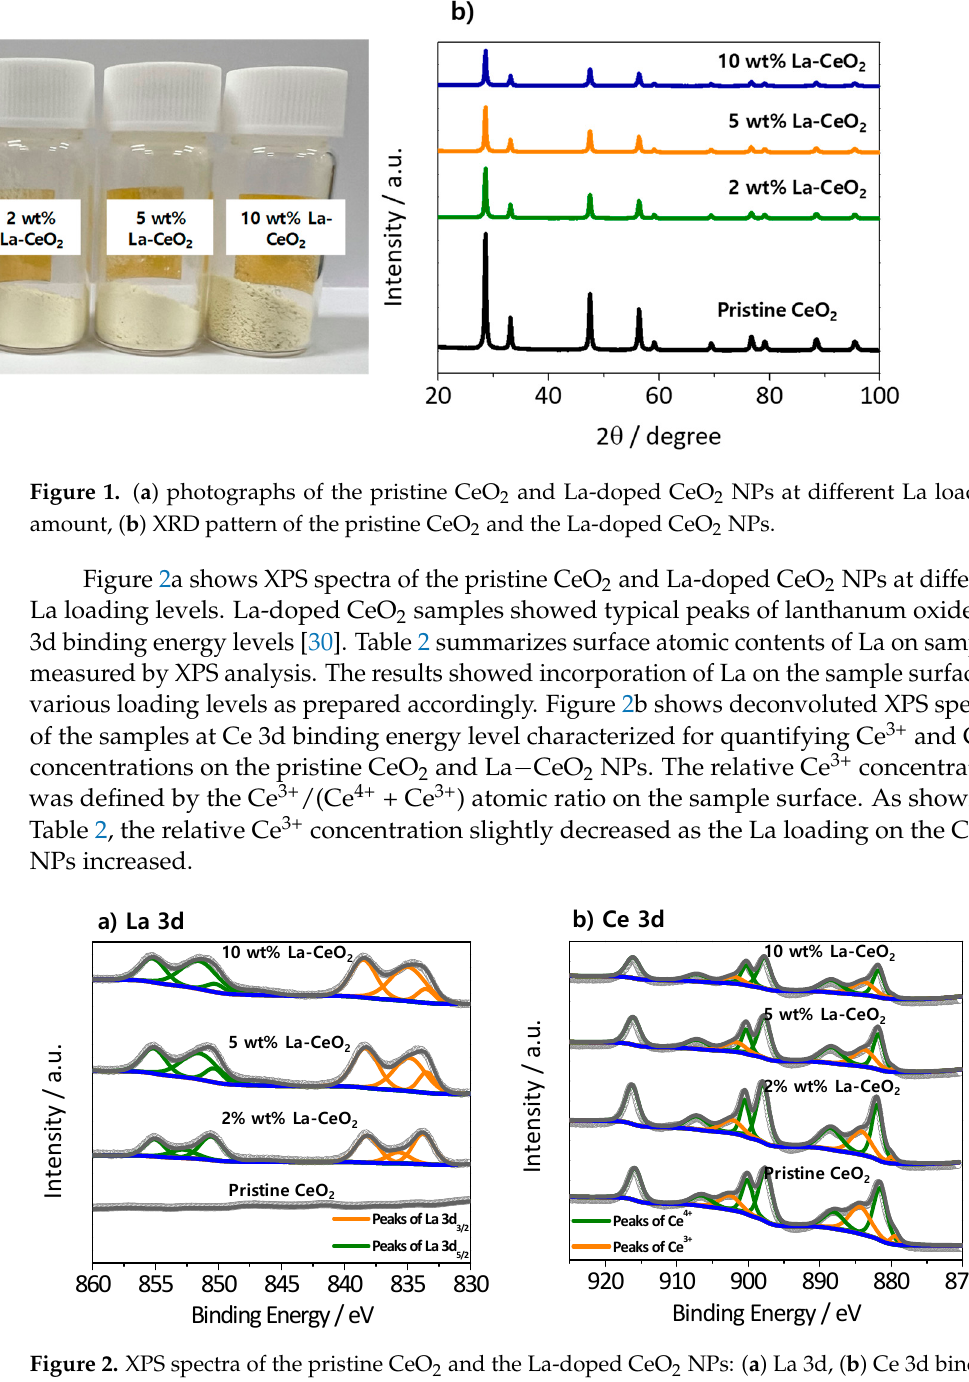
Figure 2. XPS spectra of the pristine CeO 2 and the La-doped CeO 2 NPs: ( a ) La 3d, ( b ) Ce 3d binding energy level. Table 2. Atomic content and the relative Ce concentration on the pristine CeO 2 and the La-doped CeO 2 NPs.